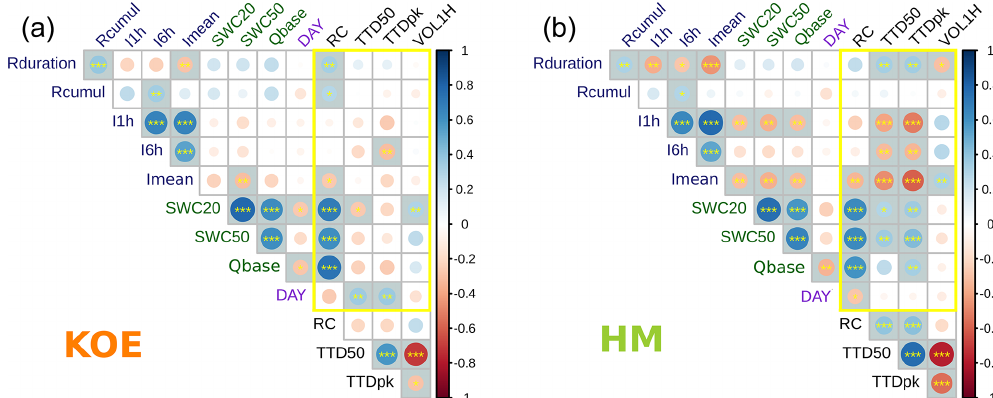
Figure 11. Kendall correlation coefficients between rainfall (blue), catchment hydrological states (green), seasonal cycle (DAY of the year), and outlet runoff properties (black). See Sect. 3.2 for more details on properties. (a) and (b) refer to KOE and HM catchment section, respectively. The size and the color of the circles are related to the Kendall coefficients. The yellow box highlights the scores of interest for our study. The blue background and the red stars indicate the significant correlations: ∗∗∗ when p -value < 10 − 3 ; ∗∗ when 10 − 3 <p - value < 10 − 2 ; ∗ when 10 − 2 <p -value < 2 × 10 − 2